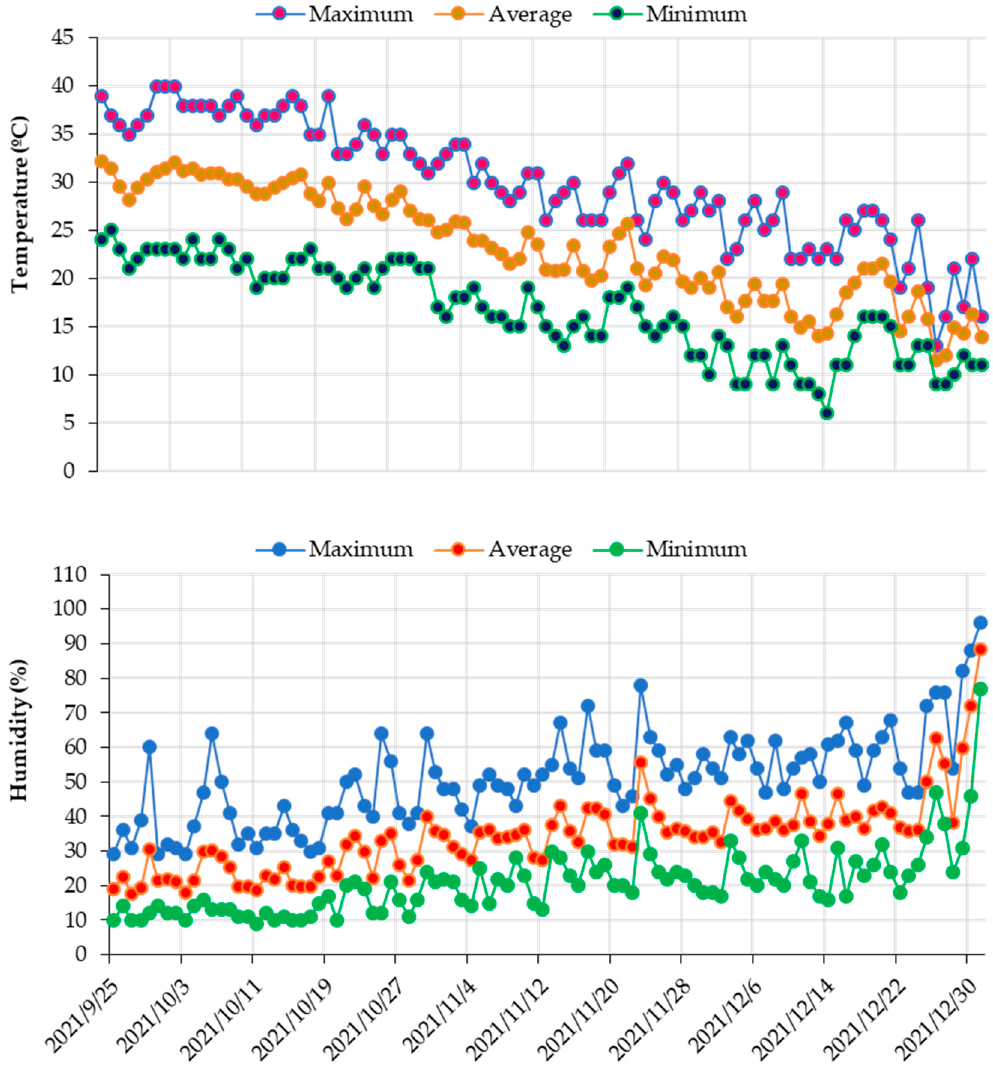
Figure 1. Average daily air temperature and relative humidity during the field experiment .